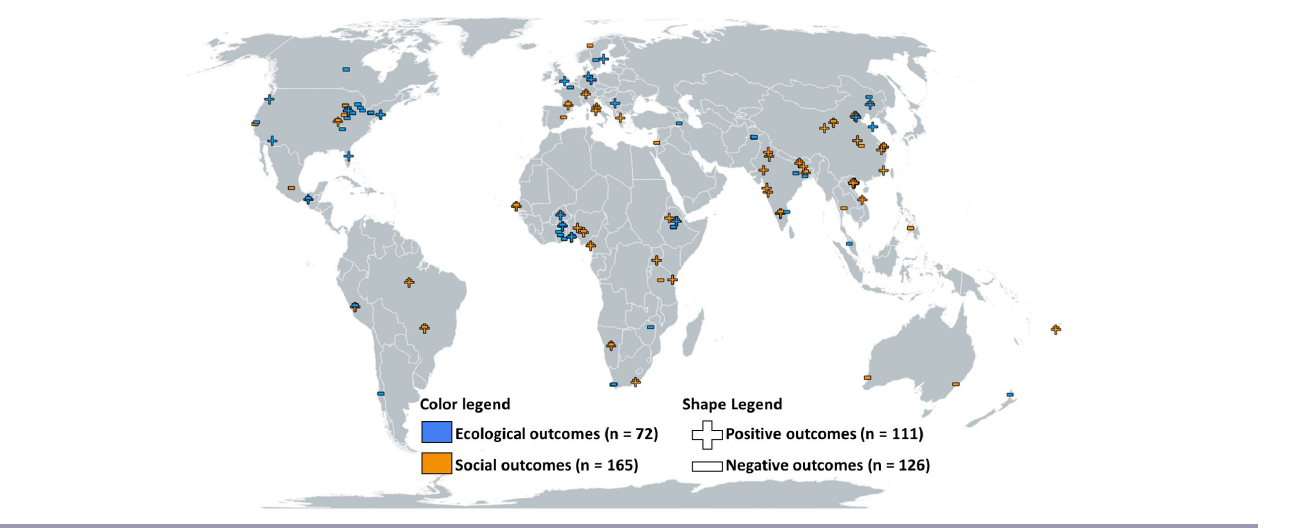
Fig. 2 . Geographical overview of the cases and their reported directions of the ecological or social outcomes of urbanization (non-conclusive cases [n = 9, with 3 ecological and 6 social outcomes] are not presented).